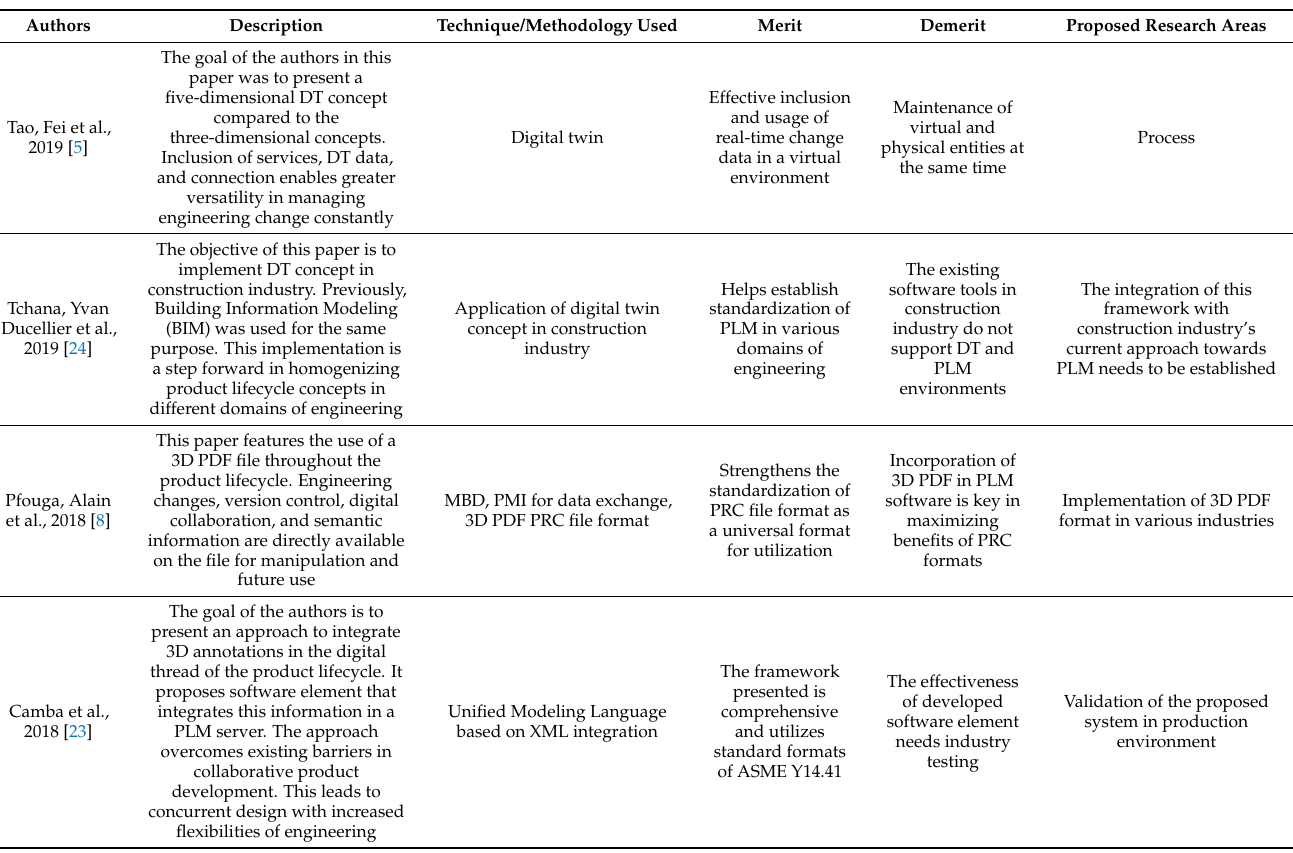
Table 3. Results of Literature Search and